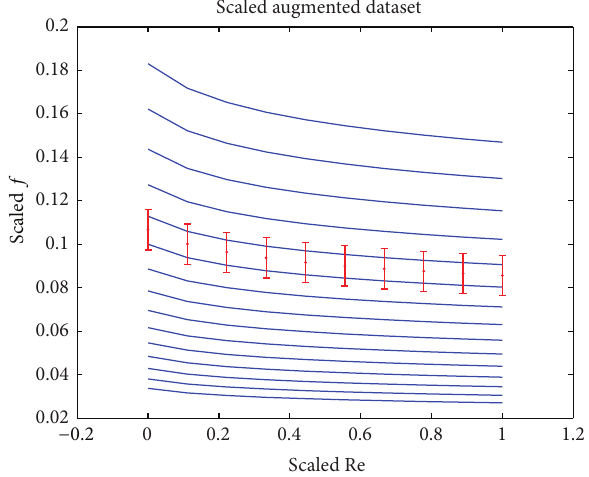
Figure 2: One uncertain parameter demonstration training set.